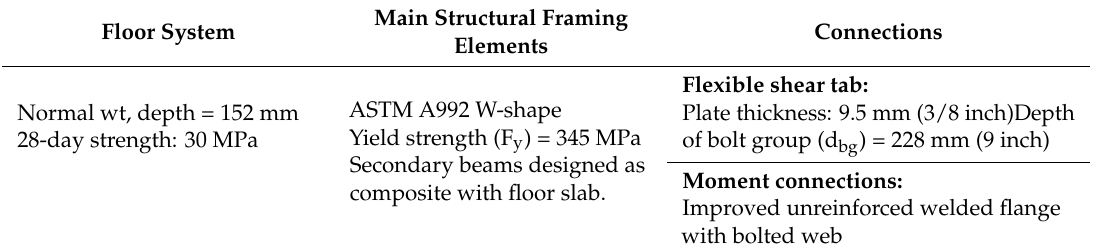
Table 1. Structural specifications for floor, connections, and framing elements.